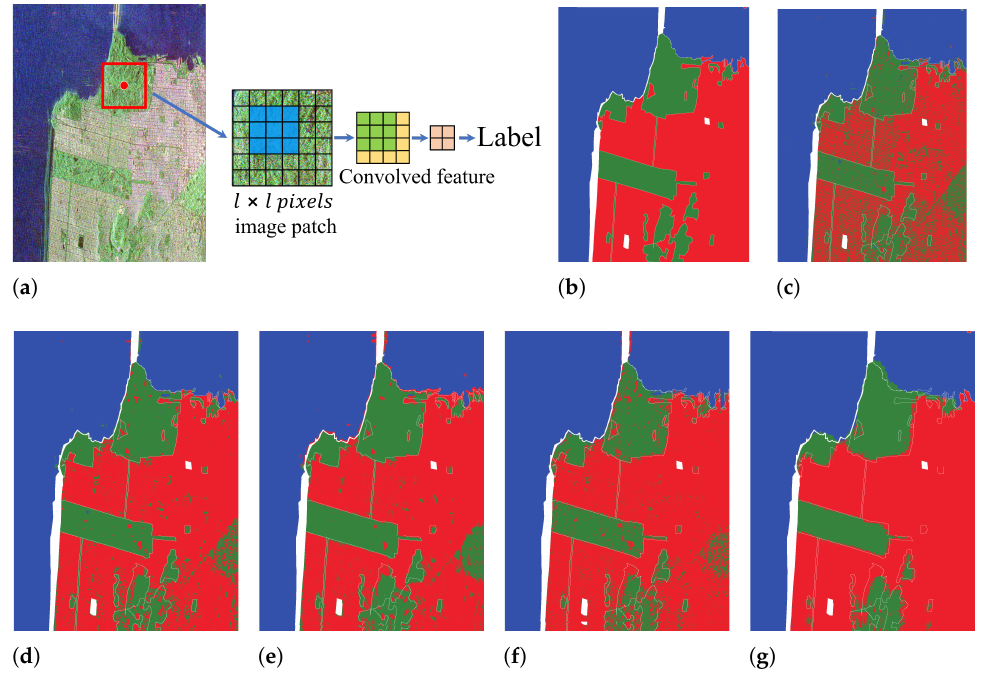
Figure 7. ( a ) Feature extraction process of deep learning network. ( b ) Ground truth map. ( c – g ) re- spectively correspond to the classification result with ResNet on Rs2-Sanf data when patch size = 5, 10, 30, 50, 100.